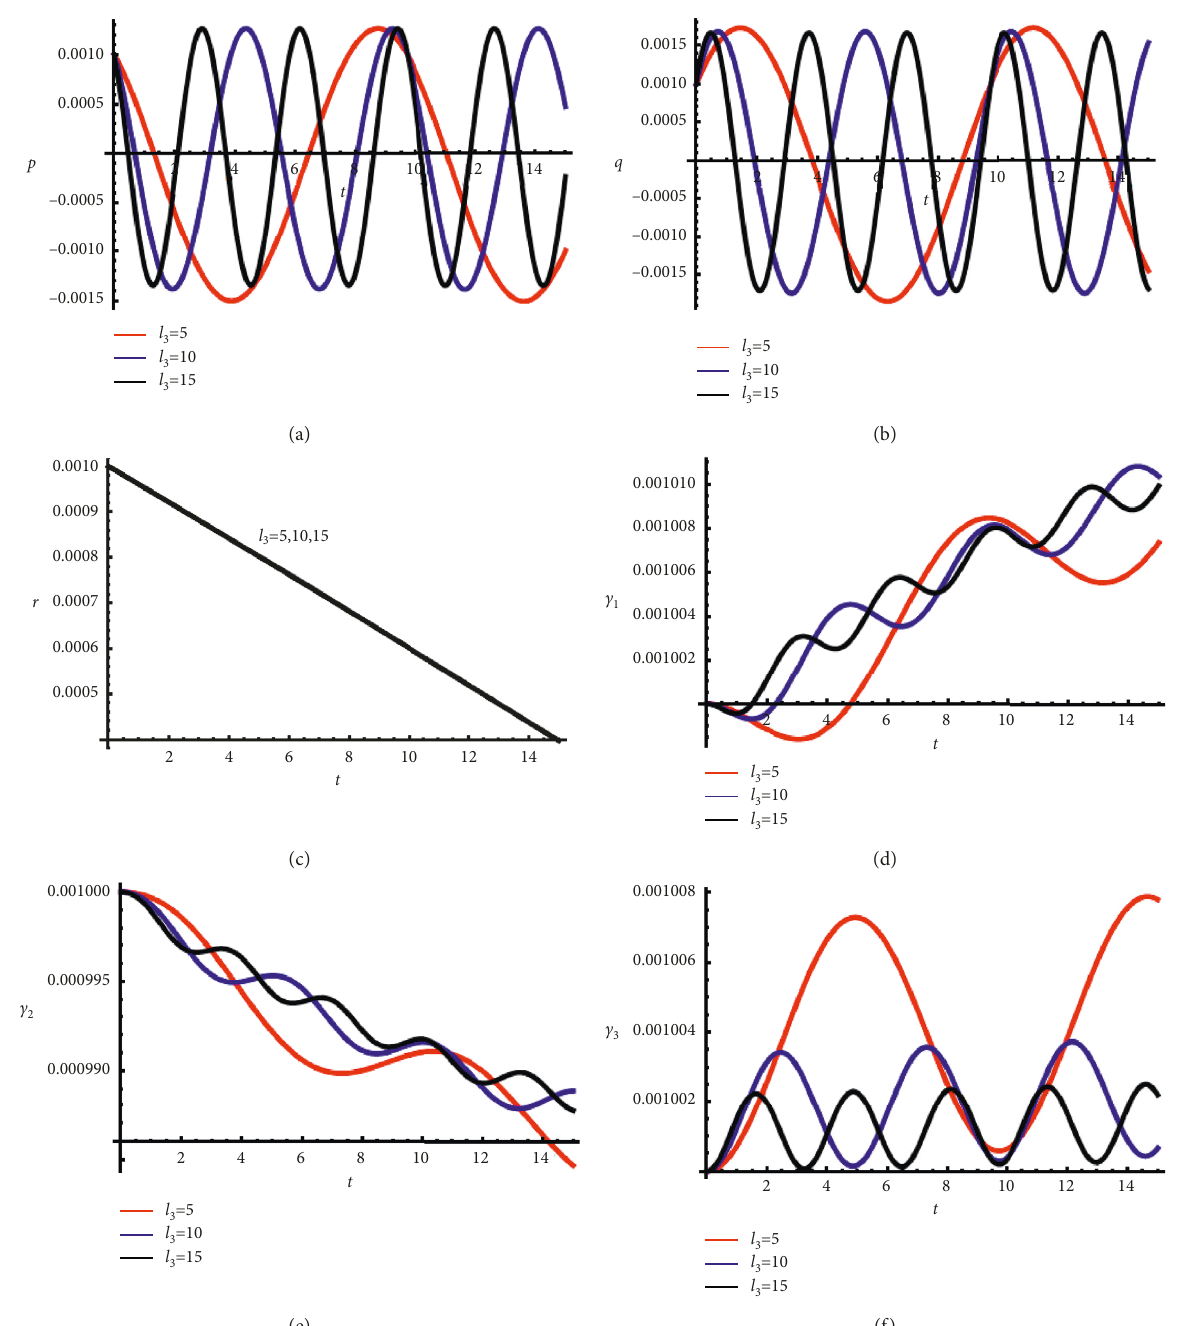
Figure 5: Time histories of the numerical solutions of p, q,r, c